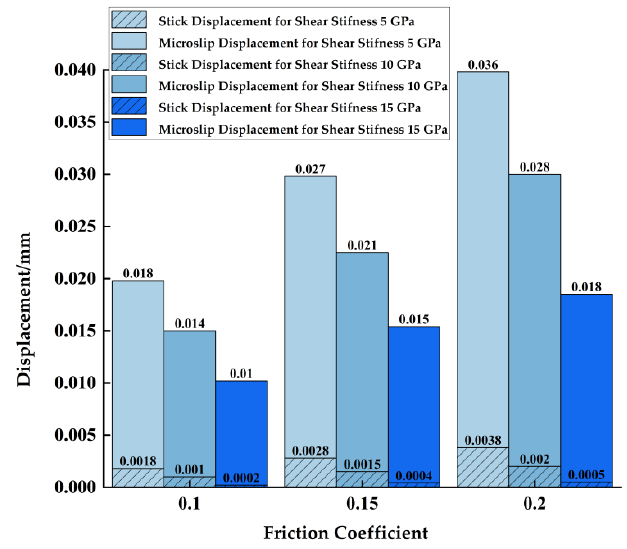
Figure 12. Histogram of stick displacement and microslip